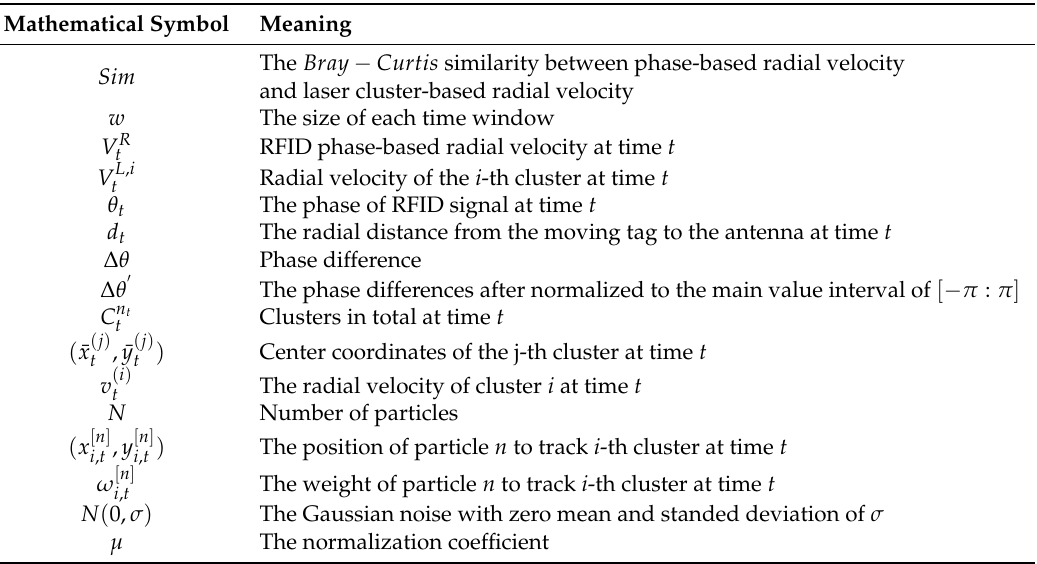
Table 1. Symbols and their